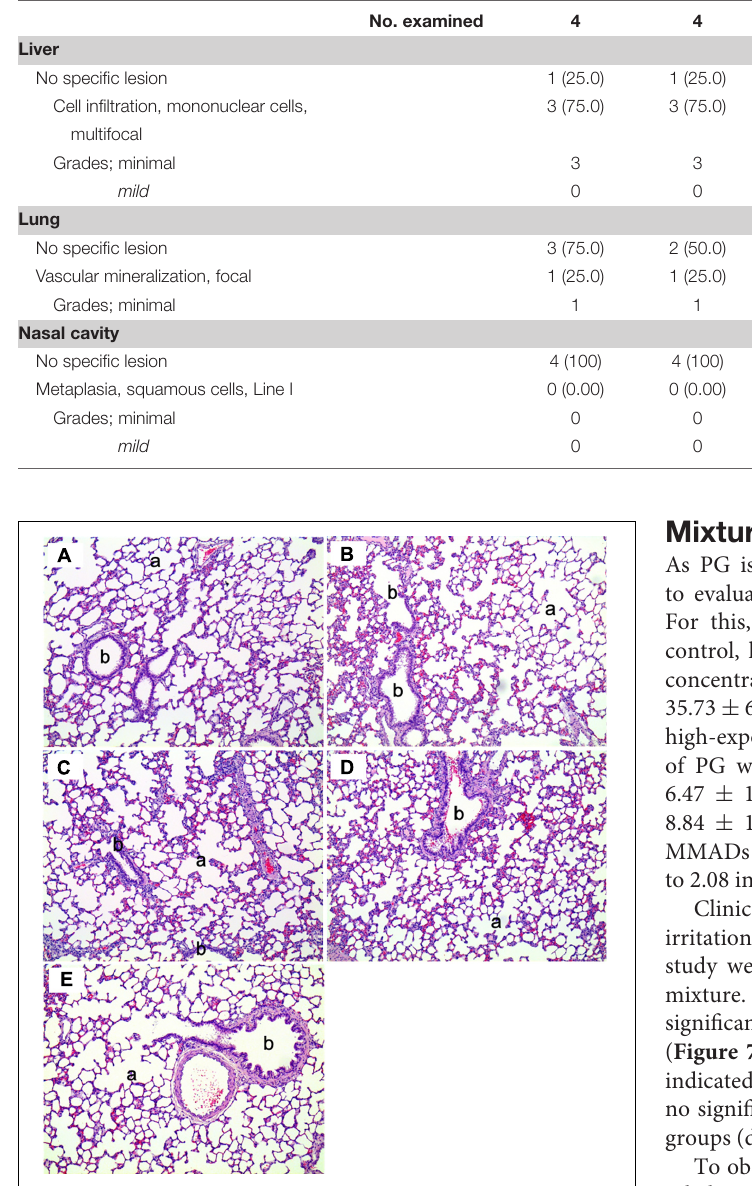
FIGURE 11 | The histopathology of the lungs in male rats exposed to the mixture of SM and PG by aerosol inhalation for 2 weeks. The results of (A–E) are the results for the control, vehicle control, low, medium, and high groups, respectively. No pathological findings resulted from the exposure of the test materials. a, alveoli; b, bronchioles. H&E staining. Magnification = × 200 for all